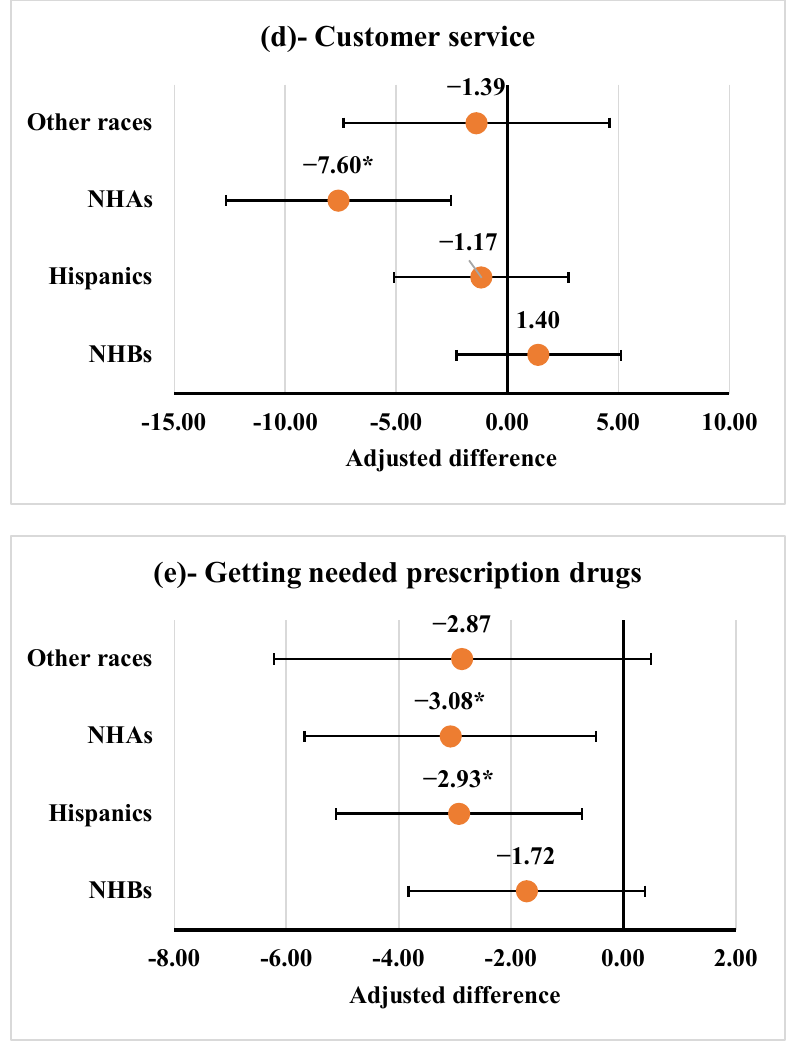
Figure 2. Adjusted differences in least-square mean estimates of patient experience measures by race/ethnicity. * Statistically significant difference at p < 0.05 level. NHAs: non-Hispanic Asians; NHBs: non-Hispanic Blacks; N = 5486 for getting needed care, N = 6323 for getting care quickly, N = 5487 for doctor communication, N = 1968 for customer service, and N = 4131 for getting needed prescription drugs. The error bars indicate 95% confidence intervals around the point estimate. Note: Adjusted difference between least-square mean estimate of a race/ethnicity category compared to non-Hispanic Whites derived from fully adjusted models. Models adjusted for case-mix variables (age when responded to survey, proxy answering questions for respondent, mental health status, general health status, low income subsidy, dual eligibility, and education), adjusted for plan type, prescription drug plan, marital status, geographic region of residence at the time of CAHPS survey, urban/rural residence status, Census Tract Poverty Indicator for neighborhoods survey year, current smoking status, tumor grade, lymph node involvement, risk of disease progression, receipt of radiation as a part of initial treatment, receipt of definitive surgery as a part of initial treatment, number of prior cancers other than prostate cancer, time between prostate cancer diagnosis and CAHPS survey, comorbidity